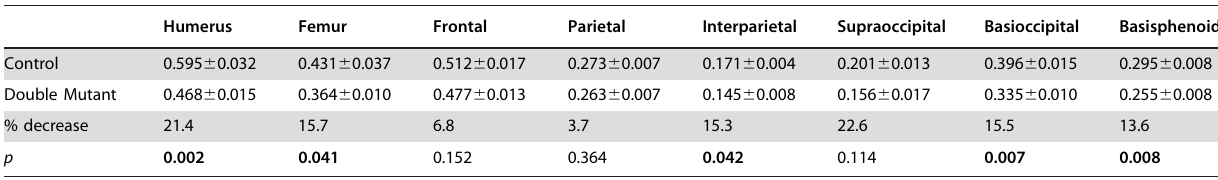
Table 3. Selected bones of Sulf1 2 / 2 Sulf2 2 / 2 embryos show decreased volume. .. ... .... ... ... .... ... ... .... ... ... .... ... ... .... ... ... .... ... ... .... ... ... .... ... ... .... ... ... .... ... ... .... ... ... .... ... ... .... ... ... .... ... ... .